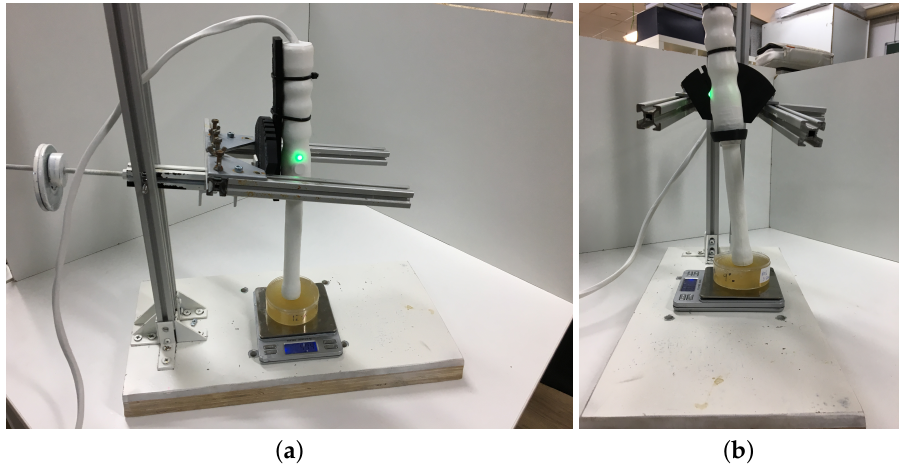
Figure 3. A counterweight device to control the applied pressure (phantom positioned on a balance) and the angle of incidence phantom-sensor. ( a ) angle of incidence 0 ◦ ; ( b ) angle of incidence 7.5 ◦